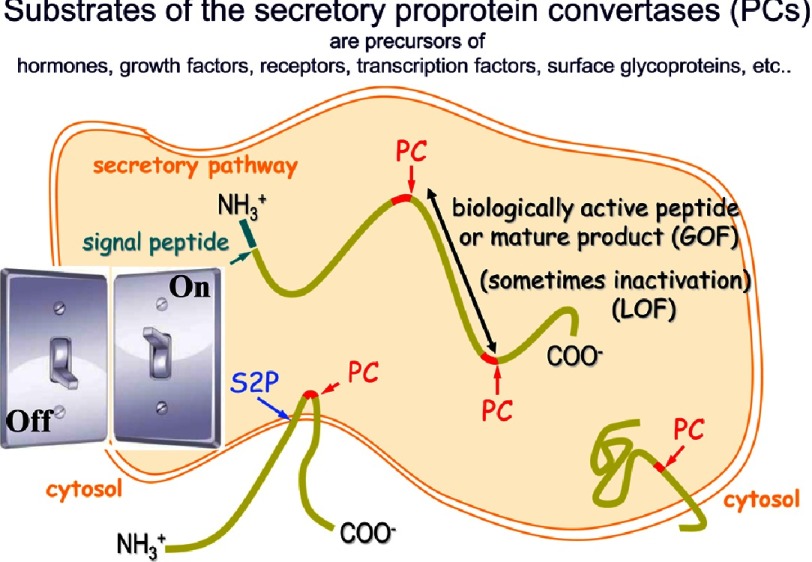
Schematic representation of the limited proteolysis of secretory precursor proteins.Notice that such PCSK-generated cleavages can either activate the cognate precursor by releasing bioactive products or inactivate it by removing bioactive moieties.